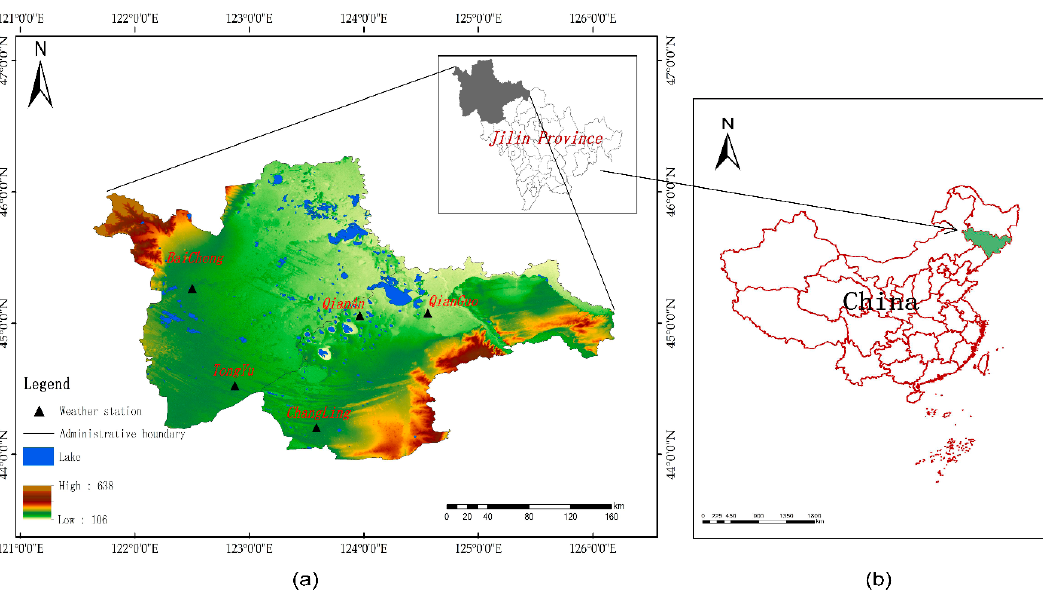
Figure 1. ( a ) Elevation map of the study area and selected weather stations; ( b ) The study area is located in Jilin Province, China.